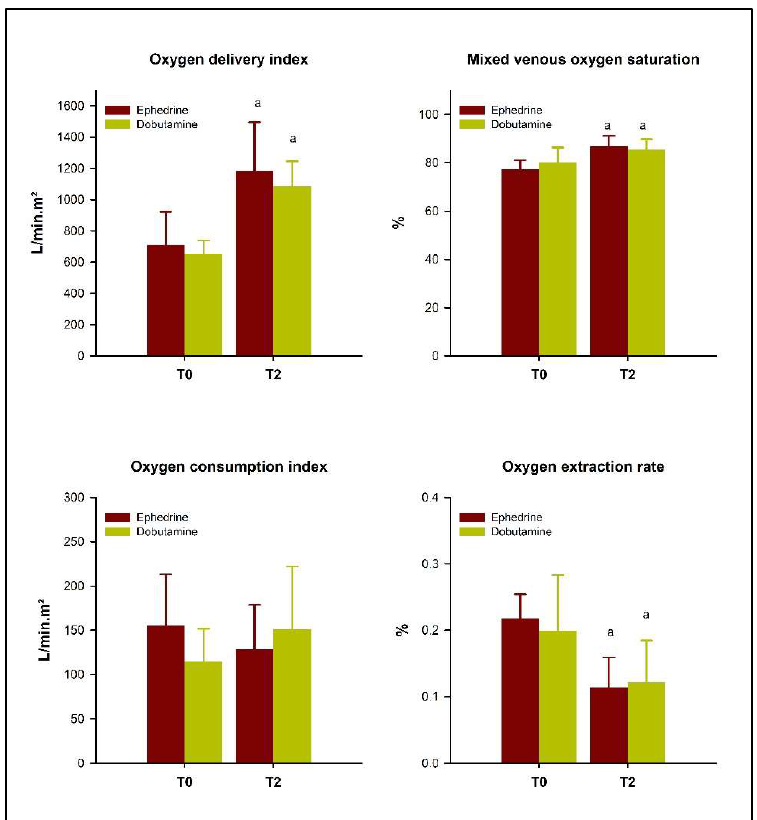
Figure 2. Changes in oxygen delivery index, mixed venous oxygen saturation, oxygen consumption index, and oxygen extraction rate in 12 isoflurane-anesthetized horses treated with dobutamine or ephedrine, at the time of the detection of hypotension (T0), and 15 min after reaching a mean arterial pressure of 70 mmHg (T2). Superscript letters indicate a significant difference ( p < 0.05) from the basal moment (a). Table 2. Mean changes (± standard deviation) of perfusion markers under the influence of ephedrine or dobutamine infusion in 13 isoflurane-anesthetized horses at the time of the detection of hypotension (T0), and 15 min after reaching a mean arterial pressure of 70 mmHg (T2). Ephedrine Dobutamine Variables T0 T2 T0 T2 Lactate (mmol/L) 2.6 ± 1.2 2.4 ± 1 2.7 ± 0.6 2.9 ± 0.6 pH 7.37 ± 0.04 7.38 ± 0.08 7.38 ± 0.04 7.34 ± 0.03 HCO 3 - (mmol/L) 26 ± 3 27 ± 4 28 ± 4 29 ± 2 SpO 2 (%) 98 ± 1 97 ± 2 98 ± 1 97 ± 1 PaO 2 (mmHg) 186 ± 30 194 ± 80 224 ± 43 226 ± 60 PaCO 2 (mmHg) 46 ± 2.1 49 ± 2.8 a 48 ± 2.8 43 ± 1.1 a SaO 2 (%) 99 ± 0.7 99 ± 0.5 99 ± 0.2 99 ± 0.4 CaO 2 (L/dL) 17.2 ± 3.6 20.7 ± 4 21 ± 4.9 21.9 ± 4.7 Ca-vO 2 (mL/dL) 343 ± 93 209 ± 69 a 267 ± 30 271 ± 142